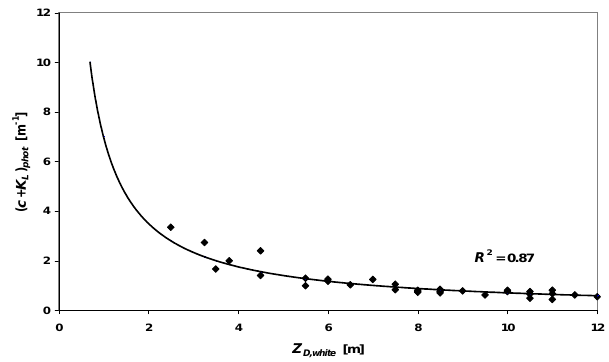
Fig. 3. ( c + K L ) phot as a function of Z D,white . The line is the func- tion ( c + K L ) phot = 7 . 0 /Z D,white . See text in Sect. 4.4 for discus- sion. R 2 is the coefficient of determination for this